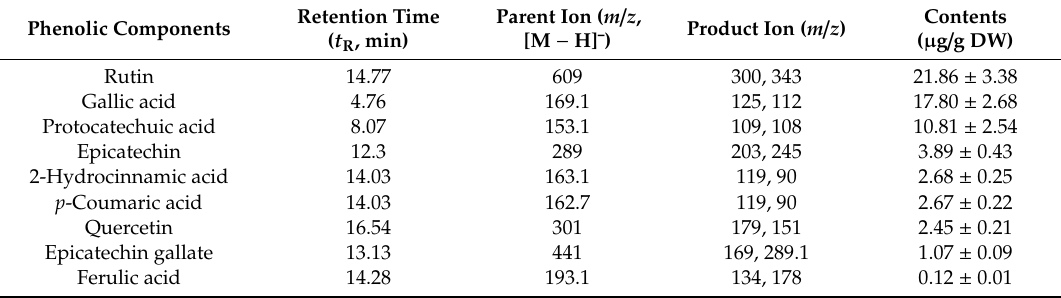
Table 5. The phenolic profile in the extract acquired under the optimal conditions of